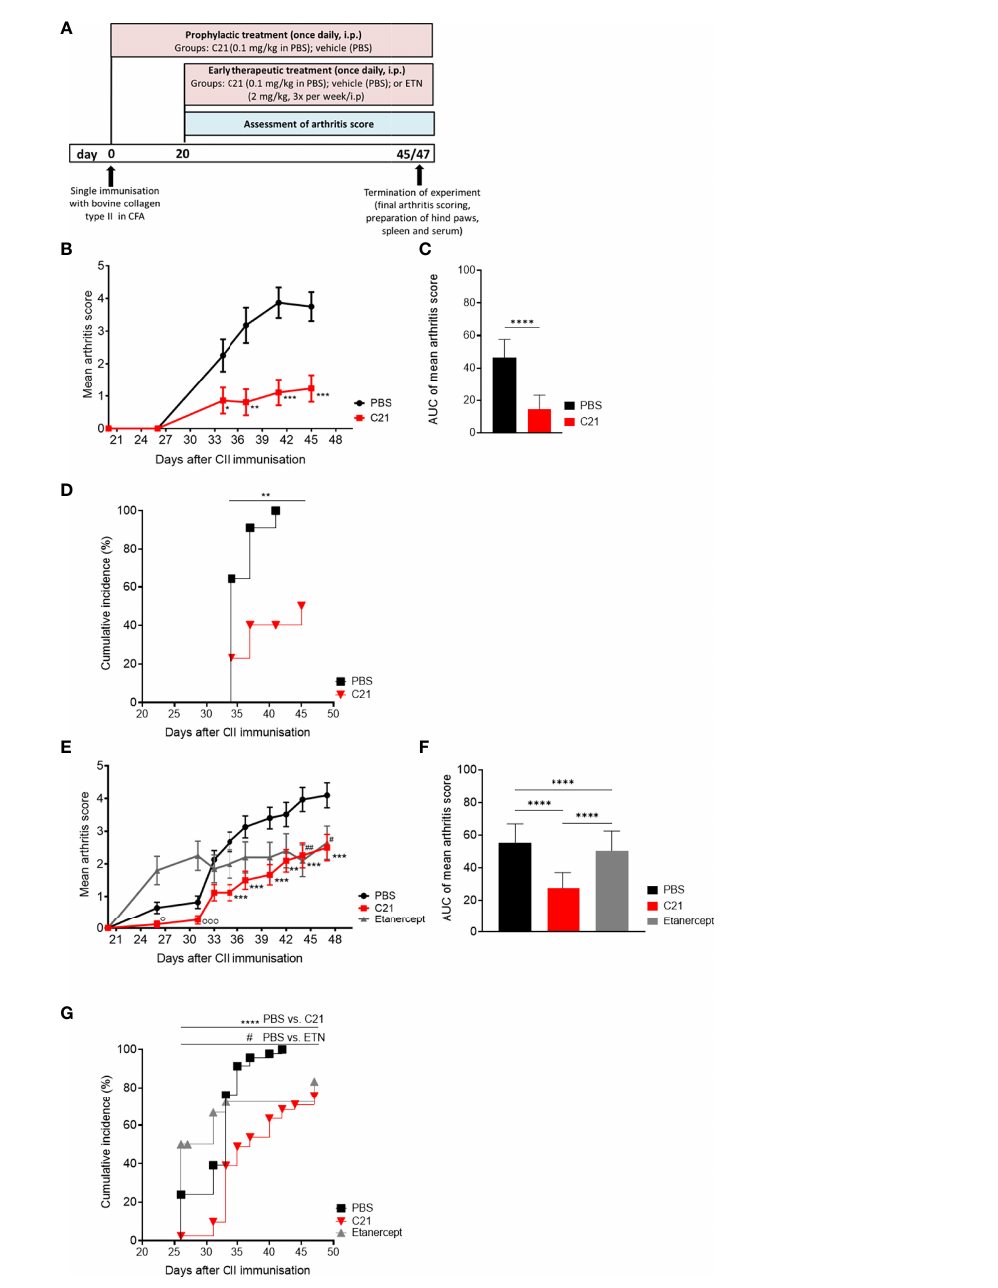
FIGURE 1 | C21-induced AT2-receptor (AT 2 R) stimulation attenuates clinical manifestations and incidence of CIA by prophylactic and early therapeutic treatment. (A) C21 treatment protocols in collagen-induced arthritis (CIA): joint in fl ammation was induced by a single intradermal immunization with bovine collagen type II (CII) in complete Freund ’ s adjuvants (CFA) at day 0. Prophylactic treatment started at day 0 and continued until day 45 with intraperitoneal (i.p.) injections of C21 once daily at a dose of 0.1 mg/kg bodyweight. The control group received PBS (vehicle). Early-therapeutic treatment started at day 20 and continued until day 47. A third group was included receiving the soluble TNF-receptor-Ig fusion protein etanercept (ETN; 2 mg/kg; 3 times a week). Arthritis score was assessed by visual inspection of paw swelling from day 20 until the end. Hind paws, spleens and sera were taken for further analyses. (B – D) Data of prophylactic treatment. PBS (n=14), C21 (n=13): (B) Mean arthritis score. P*<0.05, P**<0.01, P***<0.001. (C) Area under curve analysis of mean arthritis score. P****<0.0001. (D) Cumulative incidence of CIA. P**<0.01. (E – G) Data of therapeutic treatment. PBS (n= 45), C21 (n=42), ETN (n=20). (E) Mean arthritis score. P**<0.01 C21 vs . PBS, P***<0.001 C21 vs . PBS, P # <0.05 ETN vs . PBS, P ## <0.01 ETN vs . PBS, P°<0.05 C21 vs . ETN, P ooo <0.001 C21 vs . ETN. (F) Area under curve analysis of mean arthritis score. P****<0.0001. (G) Cumulative incidence of CIA mice. P****<0.0001 C21 vs . PBS, P # <0.05 C21 vs . ETN. Values shown are the mean ± SEM. P values